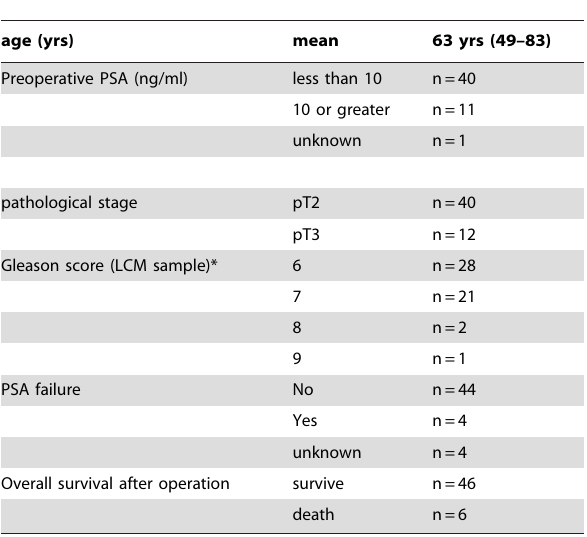
Table 1. Prostate cancer patient information